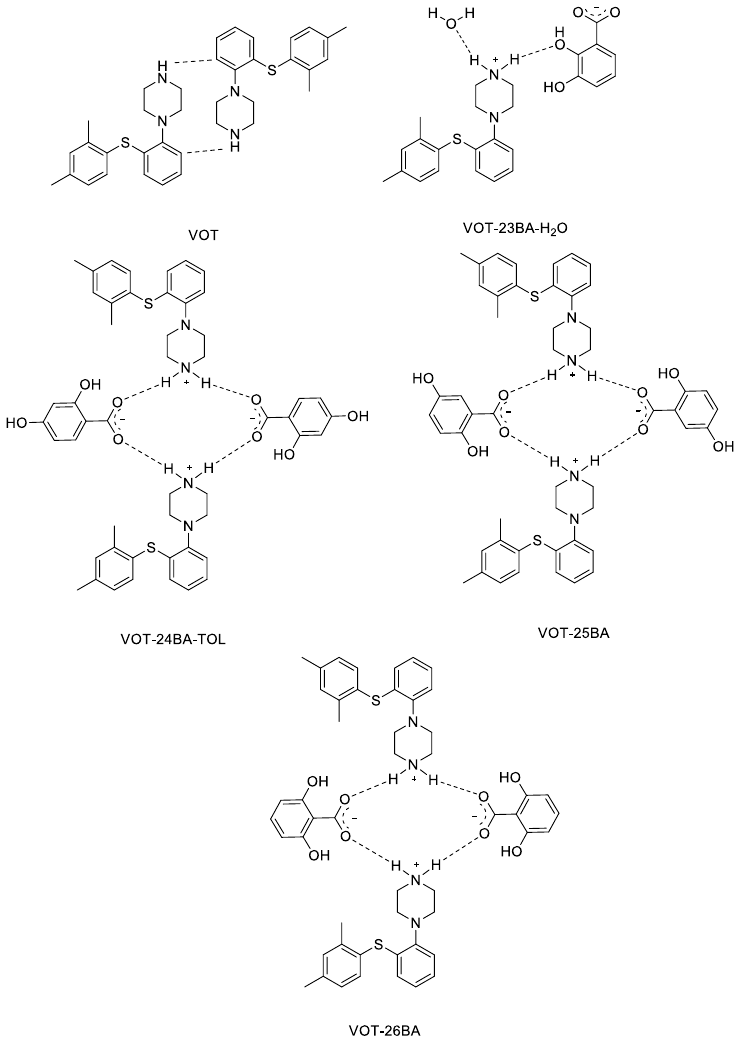
Figure 4. The [2 + 2] tetrameric structure in the VOT-26BA salt. Figure 4. The [2+2] tetrameric structure in the VOT-26BA salt.